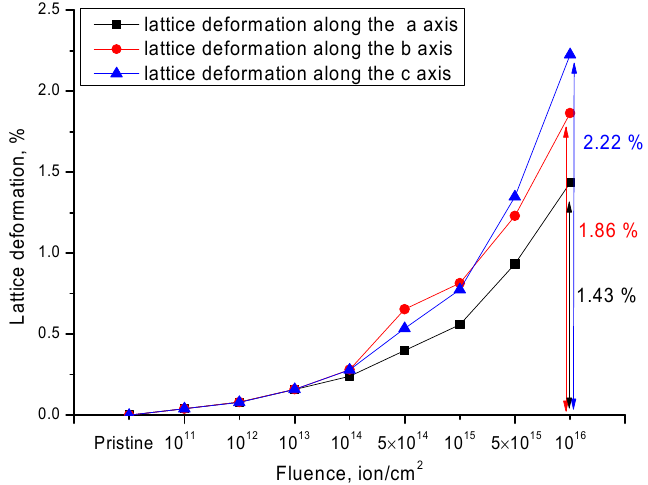
Figure 5. Dynamics of the crystal lattice deformation depending on irradiation fluence. At irradiation fluences of 10 11 -10 14 ion/cm 2 , changes in the crystal lattice parameters along all axes are equally probable, which indicates that the distortions and deformations arising as a result of irradiation are isotropic. However, the accumulation of radiation damage and the concentration of implanted Хе 22+ ions leads to an anisotropy of crystal lattice distortions, as evidenced by different deformation values. According to the data obtained, the crystal lattice is most resistant to deformation along the а crystallographic axis, whereas the lattice deformations along the b and c axes are more pronounced. Thus, it can be concluded that irradiation at high fluences leads to an anisotropic distortion of the crystal structure due to the formation of defect regions in the structure, as well as the partial replacement of atoms in the crystal lattice sites by implanted ions. The crystal lattice swelling was estimated by calculating the difference between the volume of the crystal lattice of irradiated ( V ) and initial ( V 0 ) samples and using Equation (3). The results are shown in Figure 6.